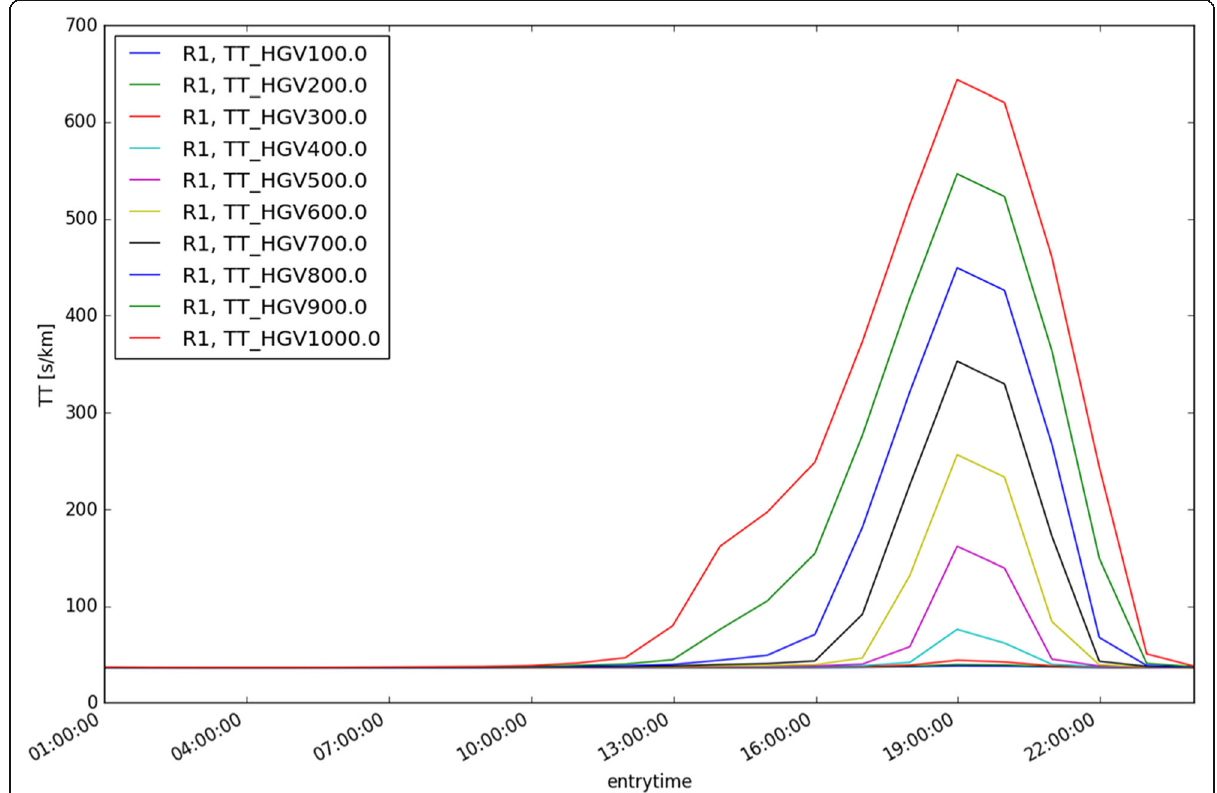
Fig. 9 Travel time depending on additional truck traffic intensity for route